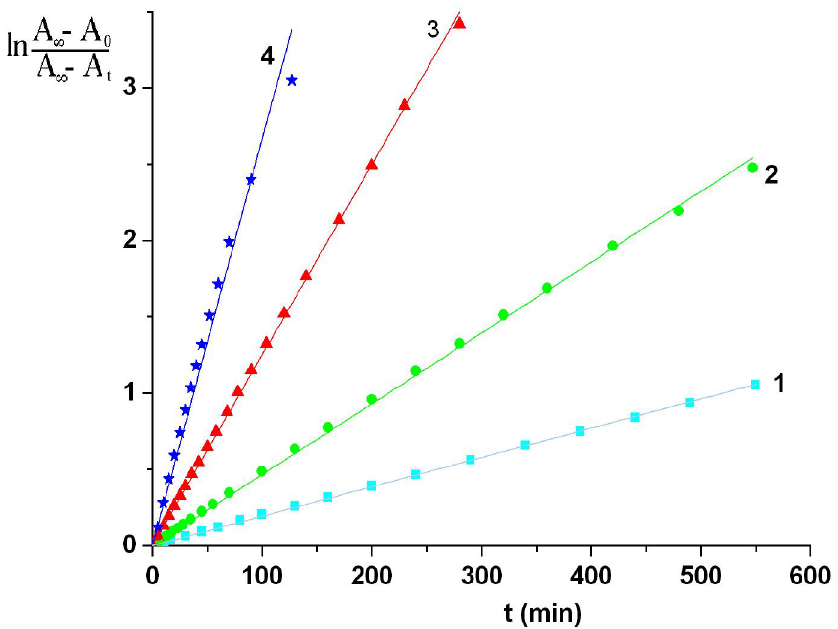
Figure 6. Kinetics of thermal cis-trans isomerization of ABM 2 in DMF solution: (1) 40 °C; (2) 50 °C; (3) 60 °C; (4) 70